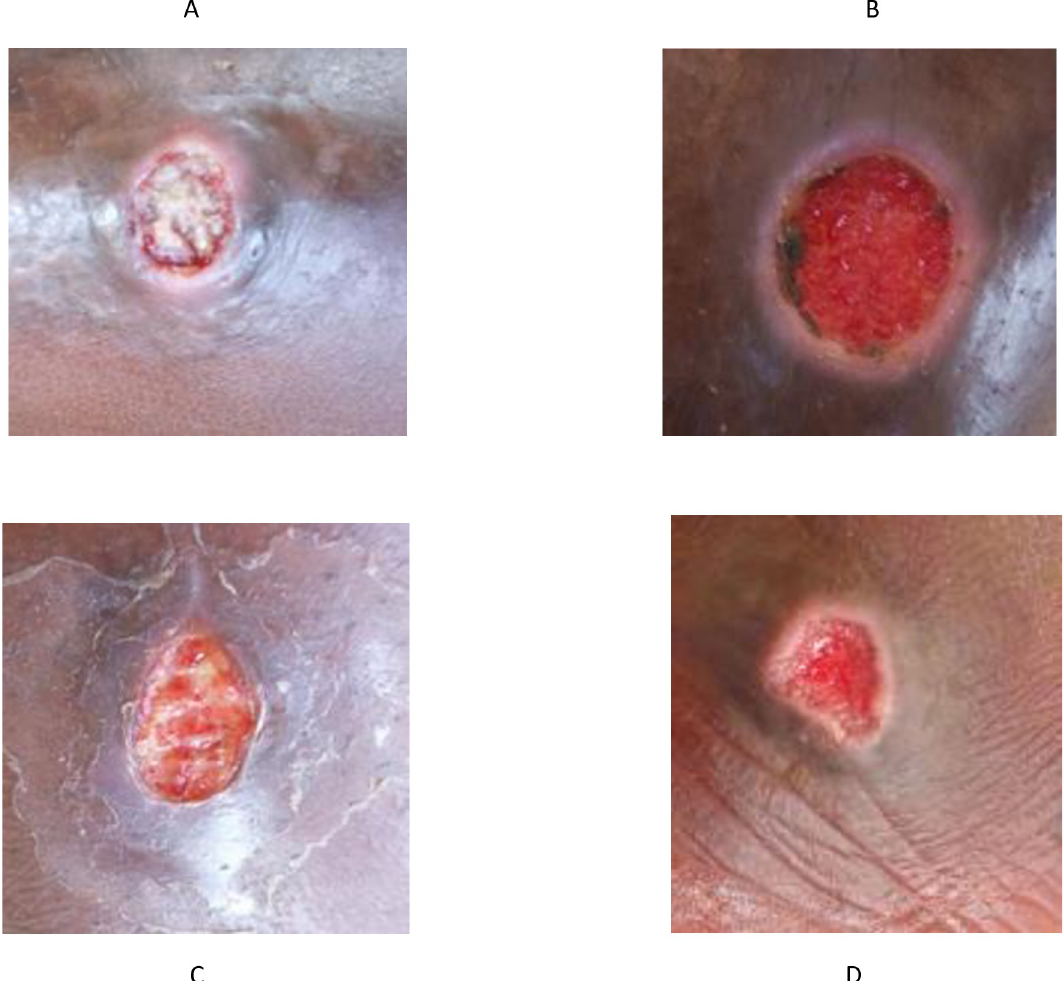
Fig 2. Examples of skin ulcers which tested positive for Leishmania parasite. A. Location: Left lower leg; dimension:10.1mm by 5.9mm. B. Location: Left lower arm; dimension:17.0mm by 15.1mm. C. Location: Left lower arm; dimension:17.6mm by 11.0mm. D. Location: Left lower leg; dimension:14.4mm by